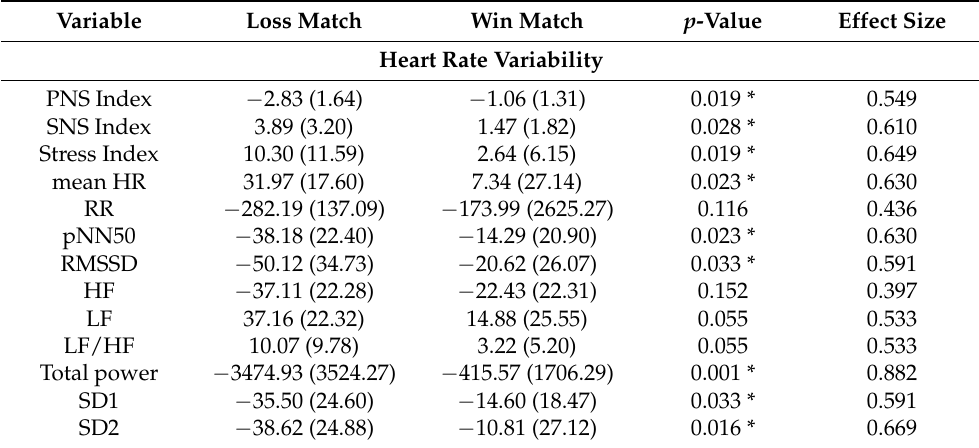
Table 4. Impact on heart rate variability of a loss and a win soccer